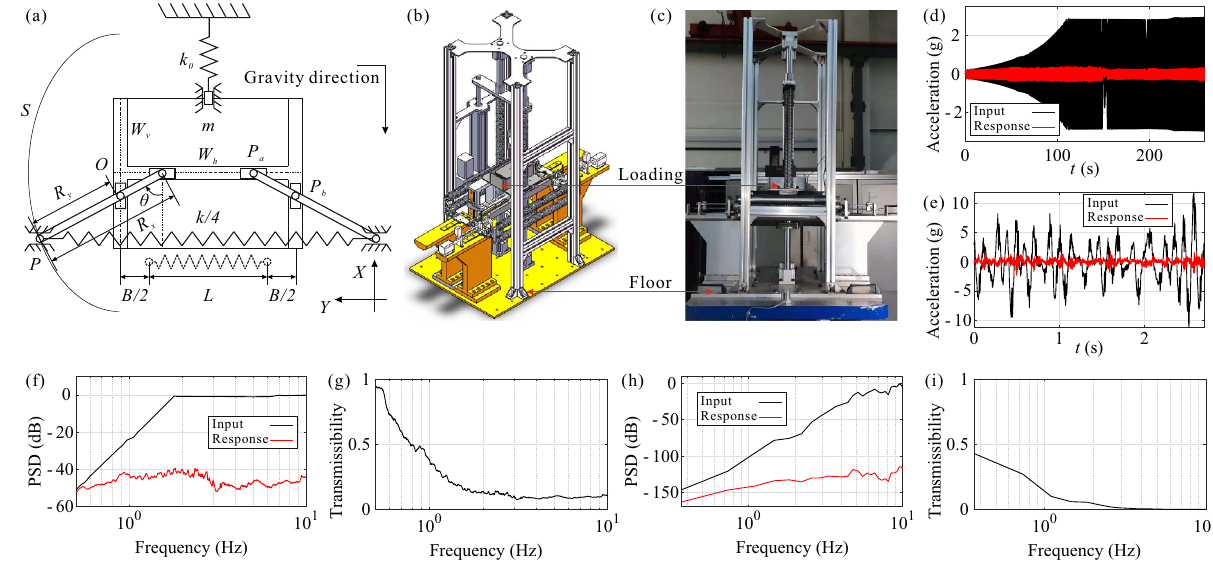
Figure 3. Experimental investigations ( a ) for the schematic of the experimental prototype, ( b ) for the CAD model of the experimental prototype, ( c ) for the panorama of the experimental prototype, ( d ) for the acceleration signal in time-domain of the frequency-sweep experiment, ( e ) for the acceleration signal in time- domain of the random vibration experiment, ( f ) for the PSD of the acceleration signal of the the frequency- sweep experiment, ( g ) for the acceleration transmissibility of the frequency-sweep experiment, ( h ) for the PSD of the acceleration signal of the the random vibration experiment, ( i ) for the acceleration transmissibility of the random vibration experiment.